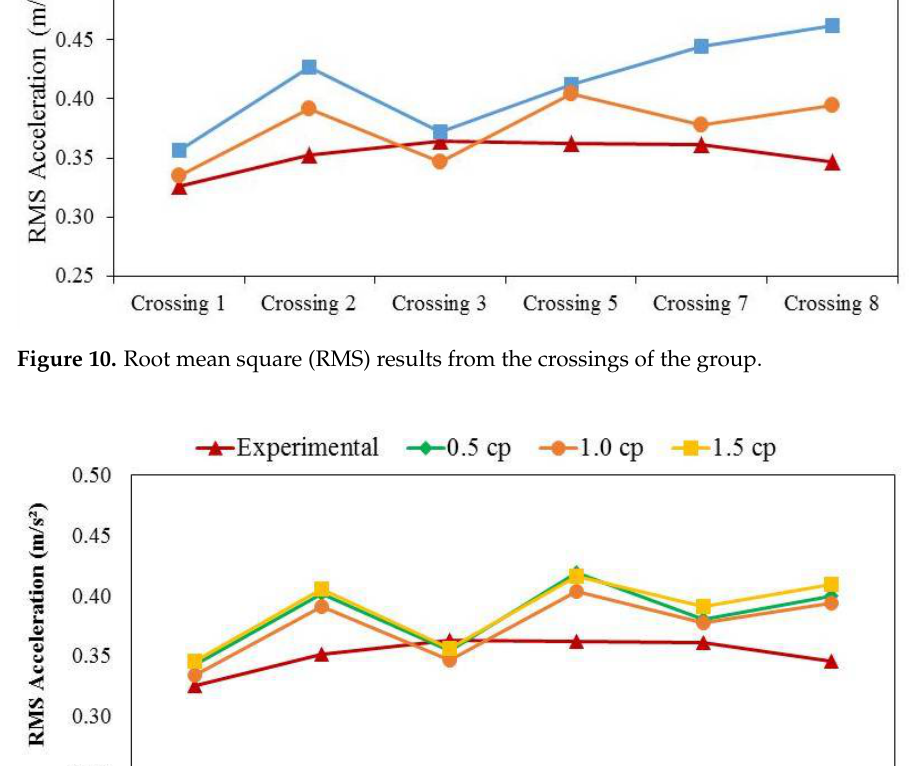
Figure 10. Root mean square (RMS) results from the crossings of the group.